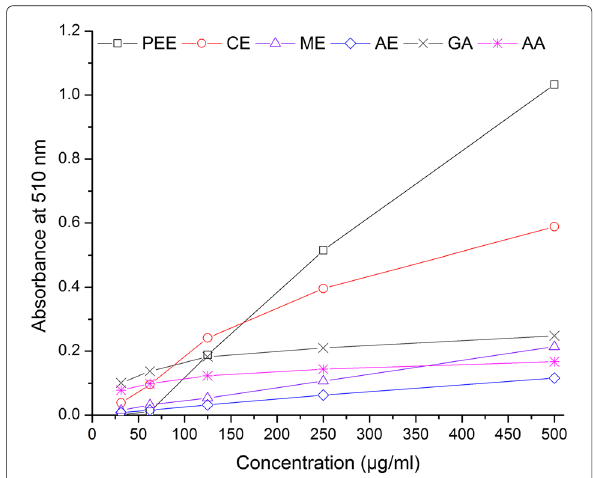
Fig. 5 Reduction of Fe 3 + ions of different extracts of C.pallida stem and standard antioxidants. All tests were done three times. PEE-Petroleum ether extract, CE- Chloroform extract, ME-Methanol extract, AE-Aqueous extract, AA-Ascorbic acid, GA-Galic acid